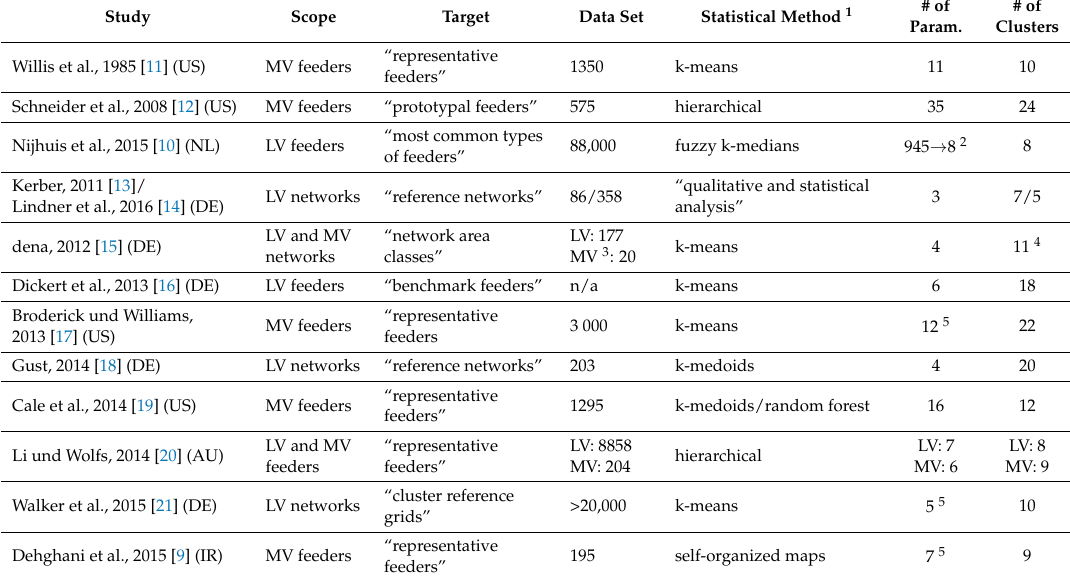
Table 1. Main characteristics of existing studies on distribution feeder/network